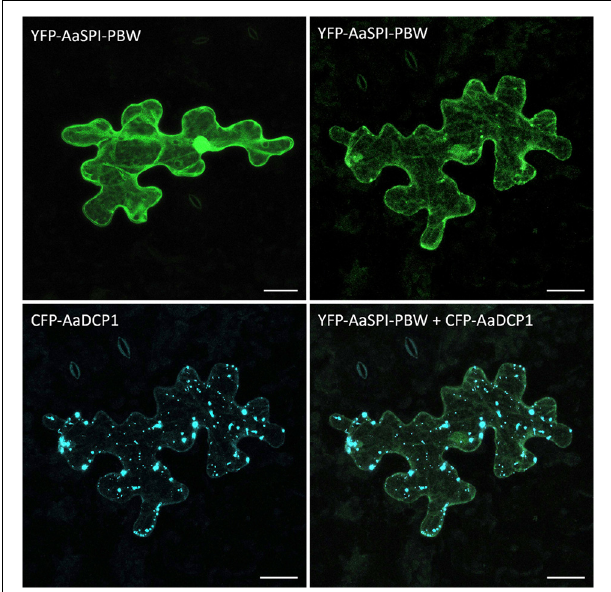
FIGURE 8 | Localization of AaSPI-PBW in pep1 epidermal pavement cells. Transient expression of YFP-AaSPI-PBW (first row), cytosolic (left) and cytosolic with dots (right); and CFP-AaDCP1 (second row), in dots (left) and in dots overlapping the expression of YFP-AaSPI-PBW. Scale bars: 25 µ